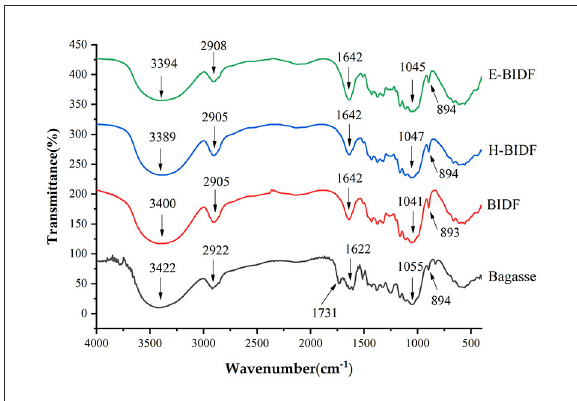
FIGURE4 The FT-IR images of bagasse, BIDF, H-BIDF and E-BIDF.